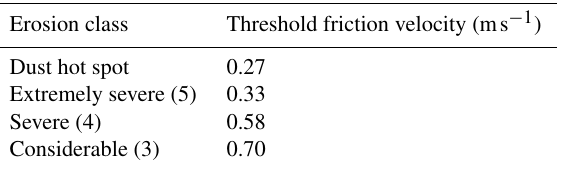
Table 1. Threshold friction velocity based on observations pre- sented by Arnalds et al. (2001) in each erosion class described by Arnalds et al. (2016).